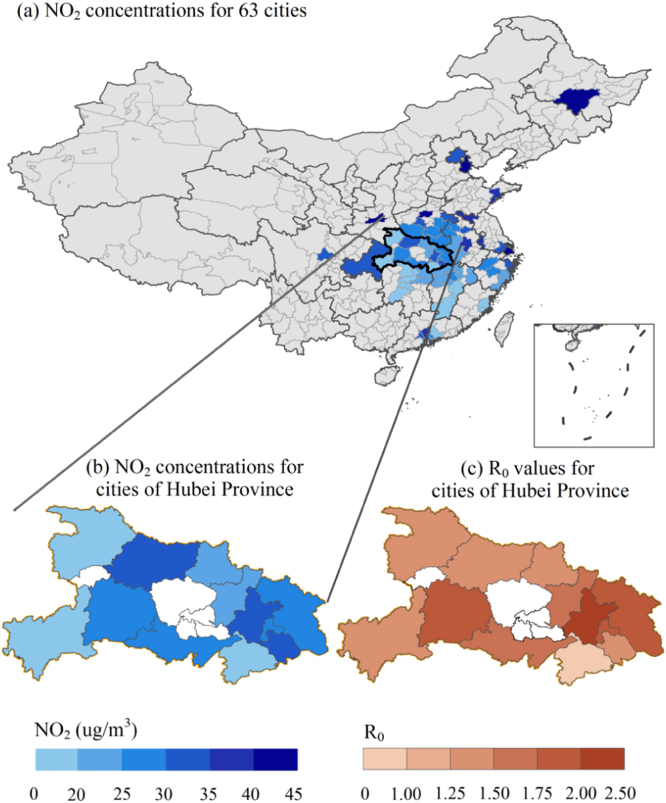
Spatial distribution of average nitrogen dioxide concentration and spreadability of COVID-19. This map of China shows the spatial distribution of the average nitrogen dioxide concentration in 63 Chinese cities from January 1, 2020 to February 8, 2020. The zoomed-in view of Hubei Province compares the spatial trend of the average nitrogen dioxide concentration (gradient blue map, bottom left) with that of the basic reproductive number R0 (gradient brown map, bottom right). (For interpretation of the references to color in this figure legend, the reader is referred to the web version of this article.)